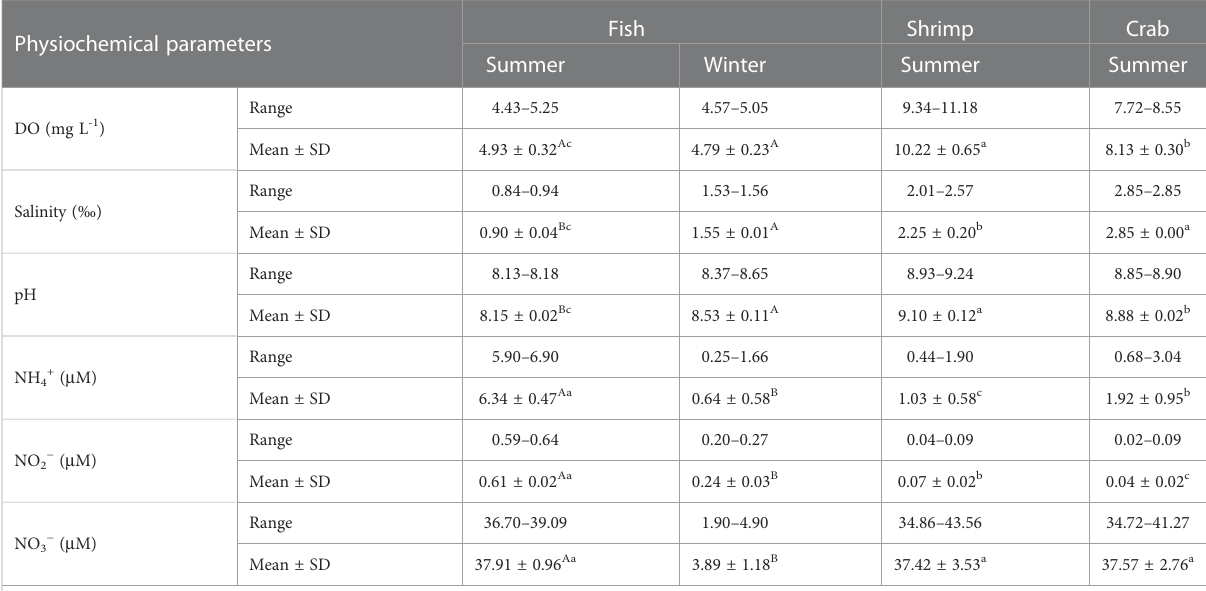
TABLE 1 Physiochemical parameters of overlying water in different reclaimed aquaculture ponds.